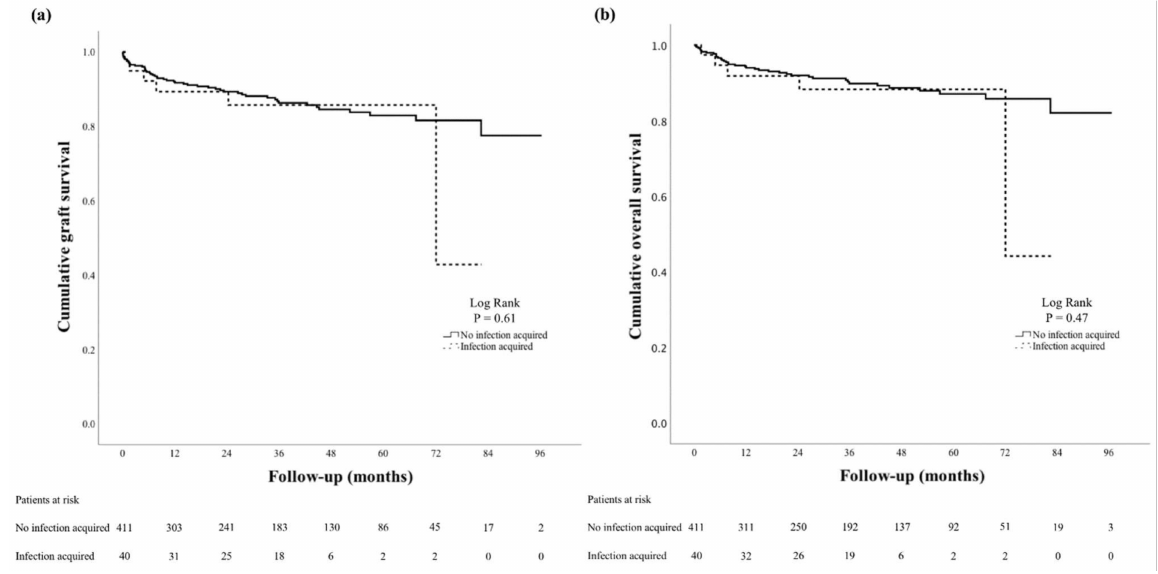
Figure 2. Survival analyses. Kaplan–Meier analyses of cumulative liver graft survival ( a ) and overall survival ( b ) in patients who did not become newly colonized with a multi-resistant organism infection and patients who did become